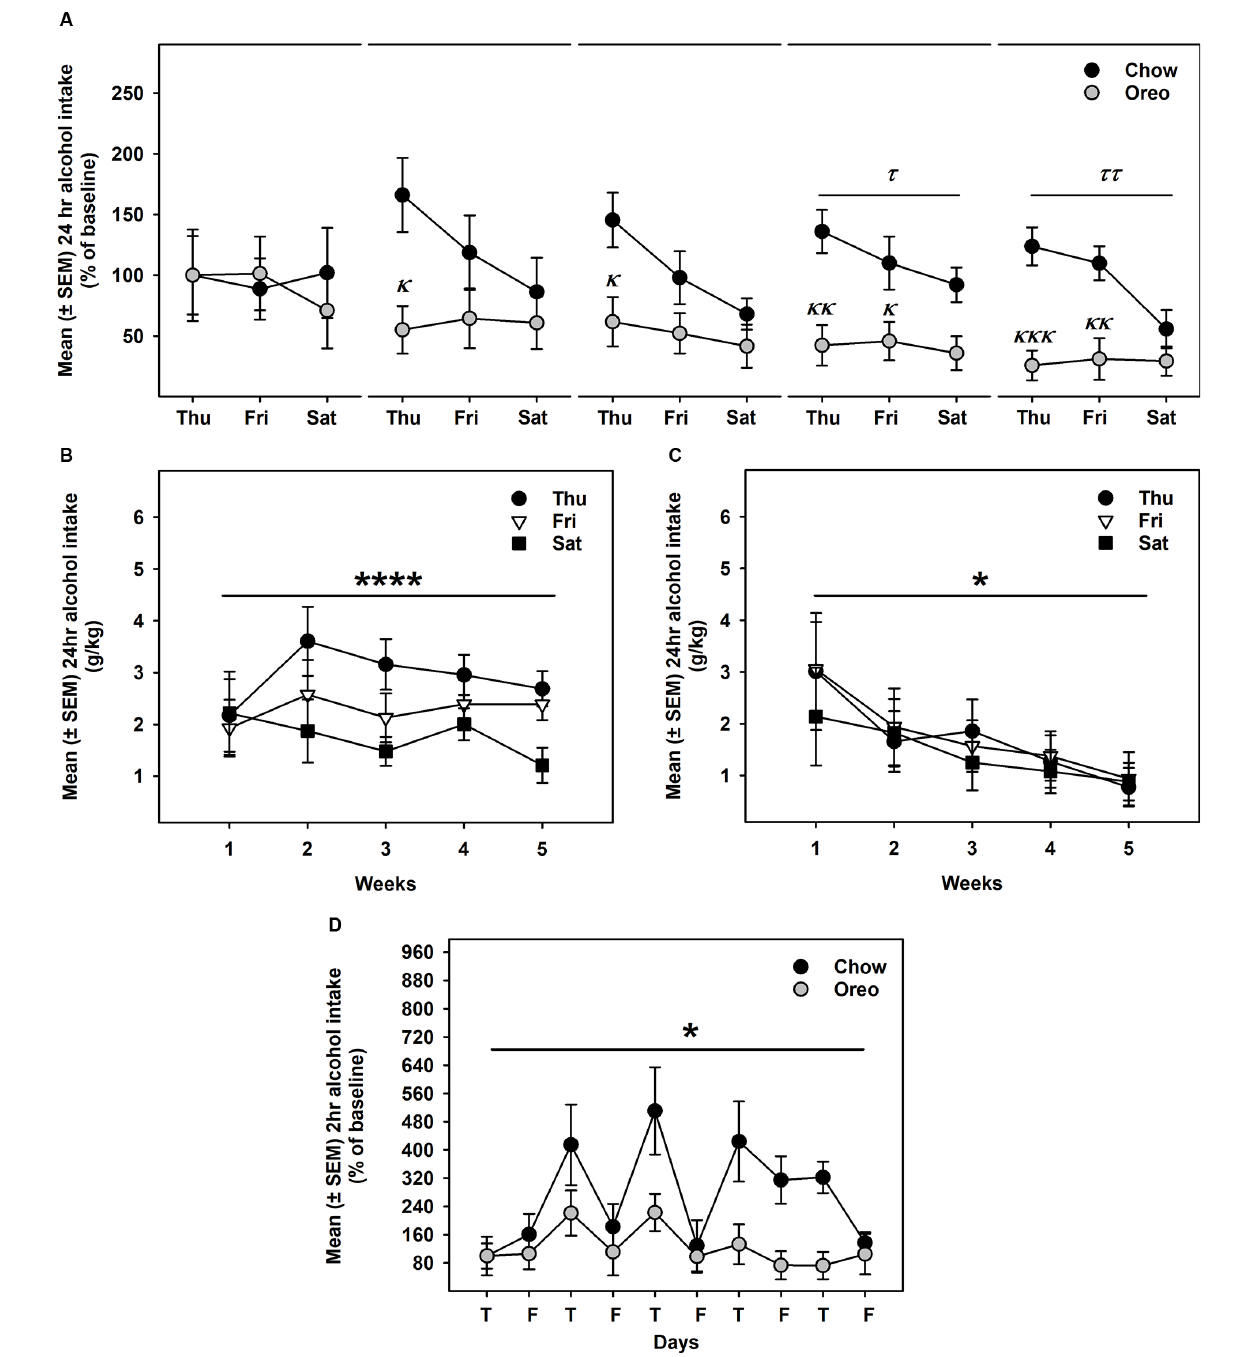
FIGURE 4 | Alcohol drinking following patterned feeding of HPF. Alcohol (20% v/v) was provided, and intake was recorded on chow-only days (Thr, Fri, Sat) for 5 weeks. (A) Mean ( ± SEM) % of baseline (day 1) alcohol intake is plotted. While there was no significant difference in alcohol intake between groups in the first week, alcohol drinking was gradually reduced in the case of the Oreo group. During the 4th and the 5th week/session, the difference markedly increased with HPF rats significantly consuming less alcohol than the chow controls. τ p = 0.01, ττ p = 0.0068 main effect of diet. κ p < 0.05, κκ p < 0.01, κκκ p < 0.001 compared to chow controls. Furthermore, alcohol consumption on each testing day was compared across the 5 weeks. (B) In chow group, a significant difference in alcohol consumption was noted among testing days, a decreasing order from Thursday to Saturday. No significant week’s effect was noted. **** p < 0.0001 main effects of testing days. (C) In the Oreo group, there was no difference in alcohol consumption over different testing days; however, there was a significant decrease in alcohol intake across the weekly testing sessions. * p < 0.05 effect of the week. (D) Similar to 24-h alcohol intake, 2-h alcohol intake in the Oreo group was significantly lower as compared to the chow controls. * p < 0.05 main effect of